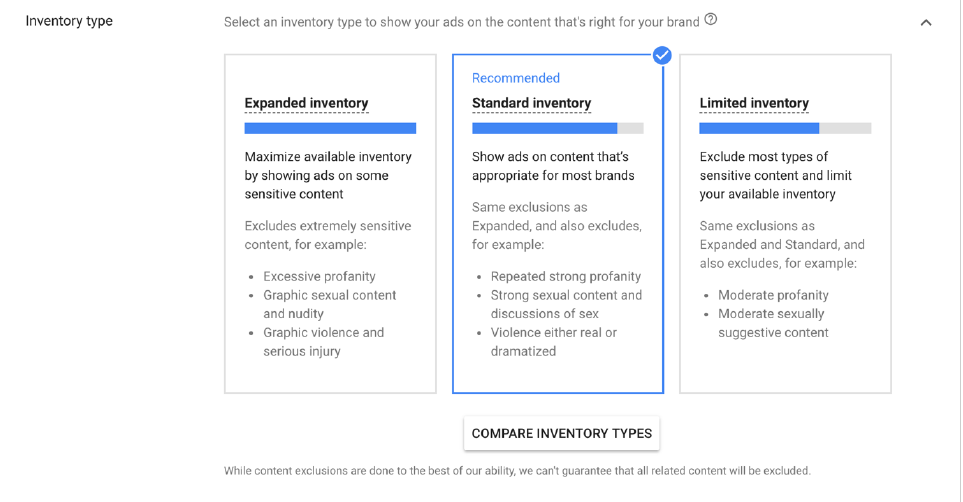
Figure 2: The three groupings of content offered to advertisers to run their advertisements